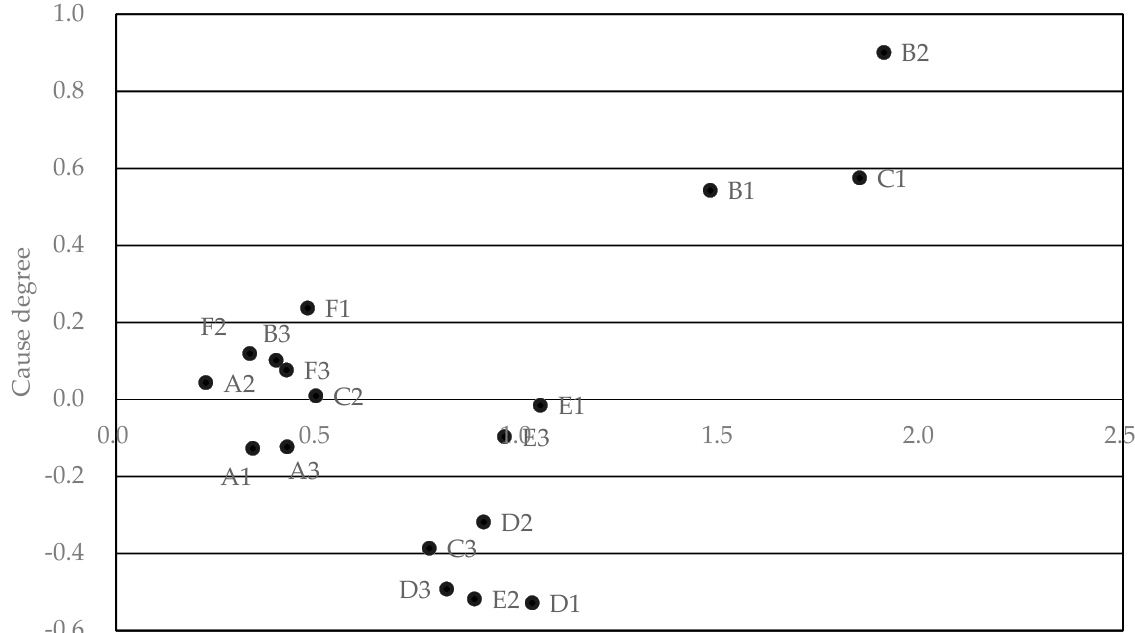
Figure 4. The cause-effect diagram for indicators.